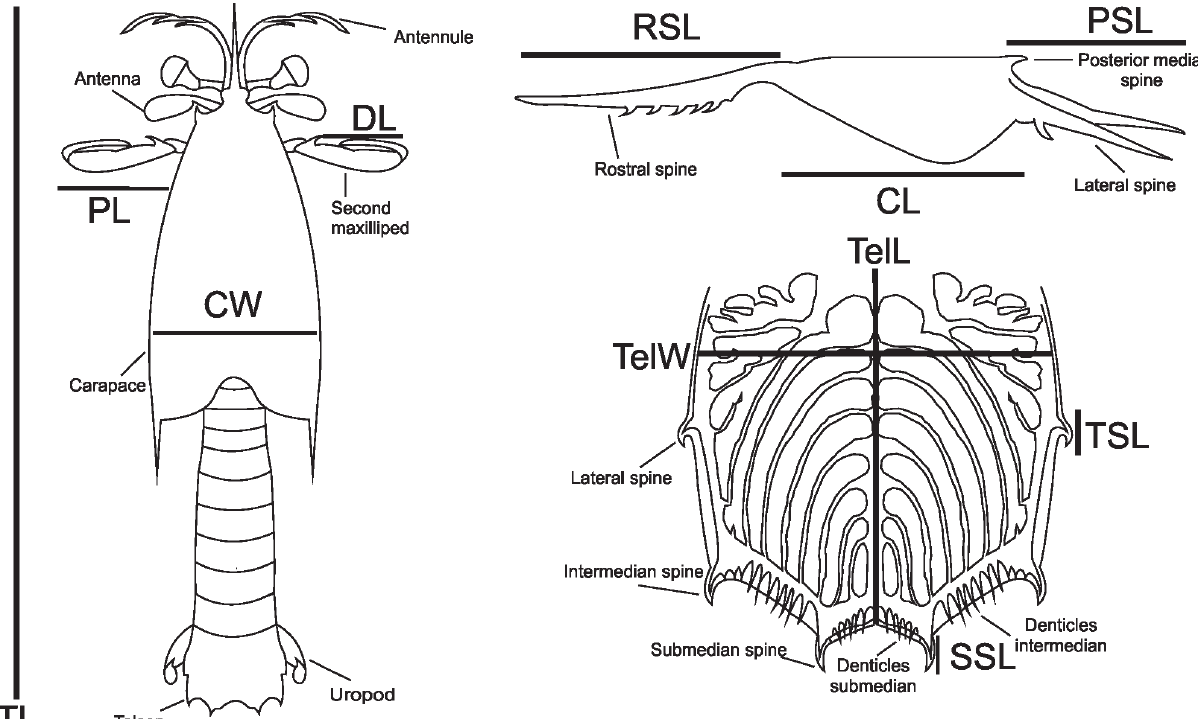
Figure 2. Stomatopod larvae. General morphology, structures and measurements. TL, total length; CL, carapace length; CW, carapace width; RSL, rostral spine length; PSL, posterolateral spines length; PL, propod length; DL, dactyl length; TelL, telson length; Telw, telson width; TSL, telson lateral spines length; SSL, telson submedian spines